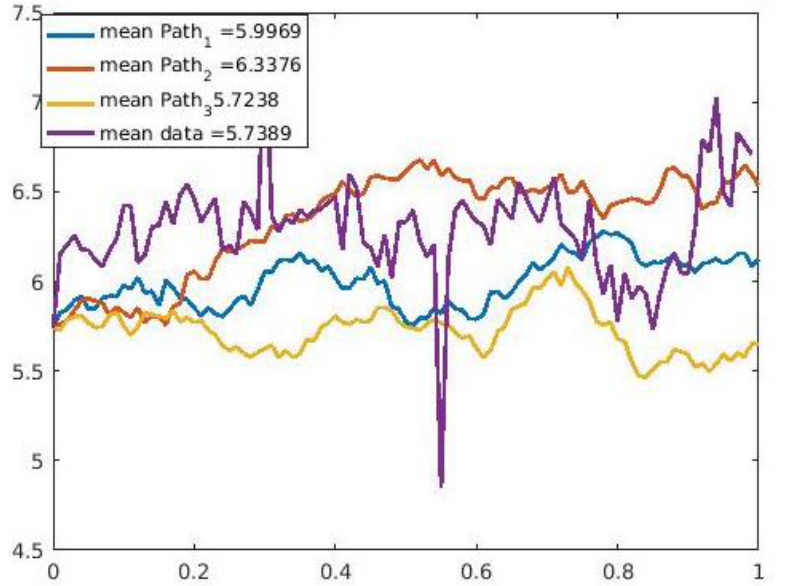
Figure 10. Graph showing three sample paths and time series plot for eruption 8. We notice that eruption 8 has 2 extreme values, which may affect the model’s performance. For this time series, we again see that sample path 3 closely predicts it and by comparison of the means, sample path 3 is closer in value to the mean of the time series